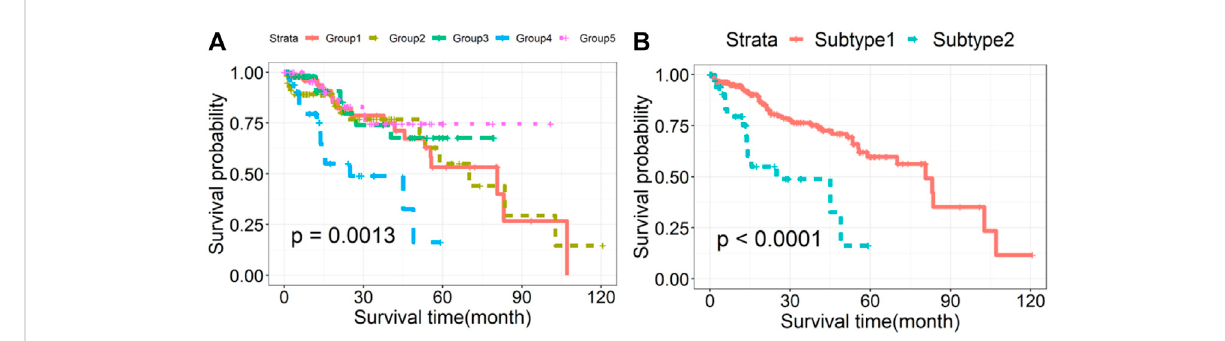
FIGURE 1 Kaplan-Meier survival curves of HCC subtypes identi fi ed by rMKL-LPP method. (A) The survival curves drawn based on the initial subtypes in HCC and (B) the survival curves of the regrouped Subtype 1 and Subtype 2.